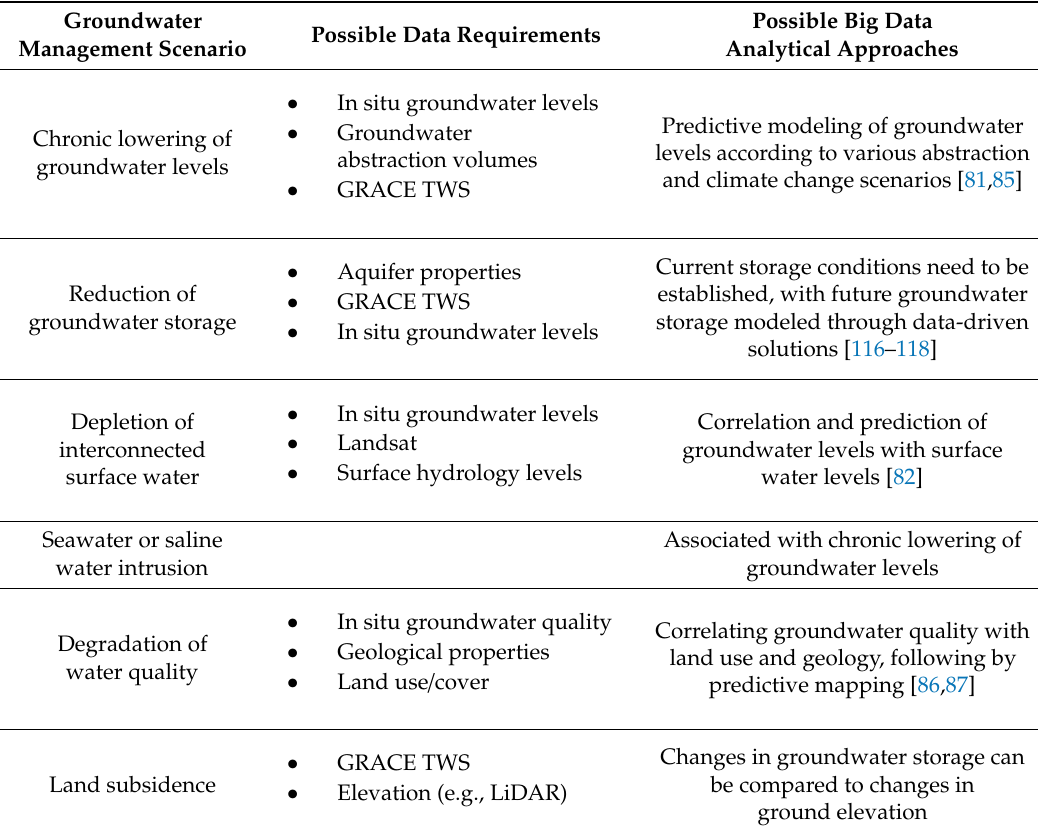
Table 5. Groundwater management scenarios and possible big data requirements and analytics